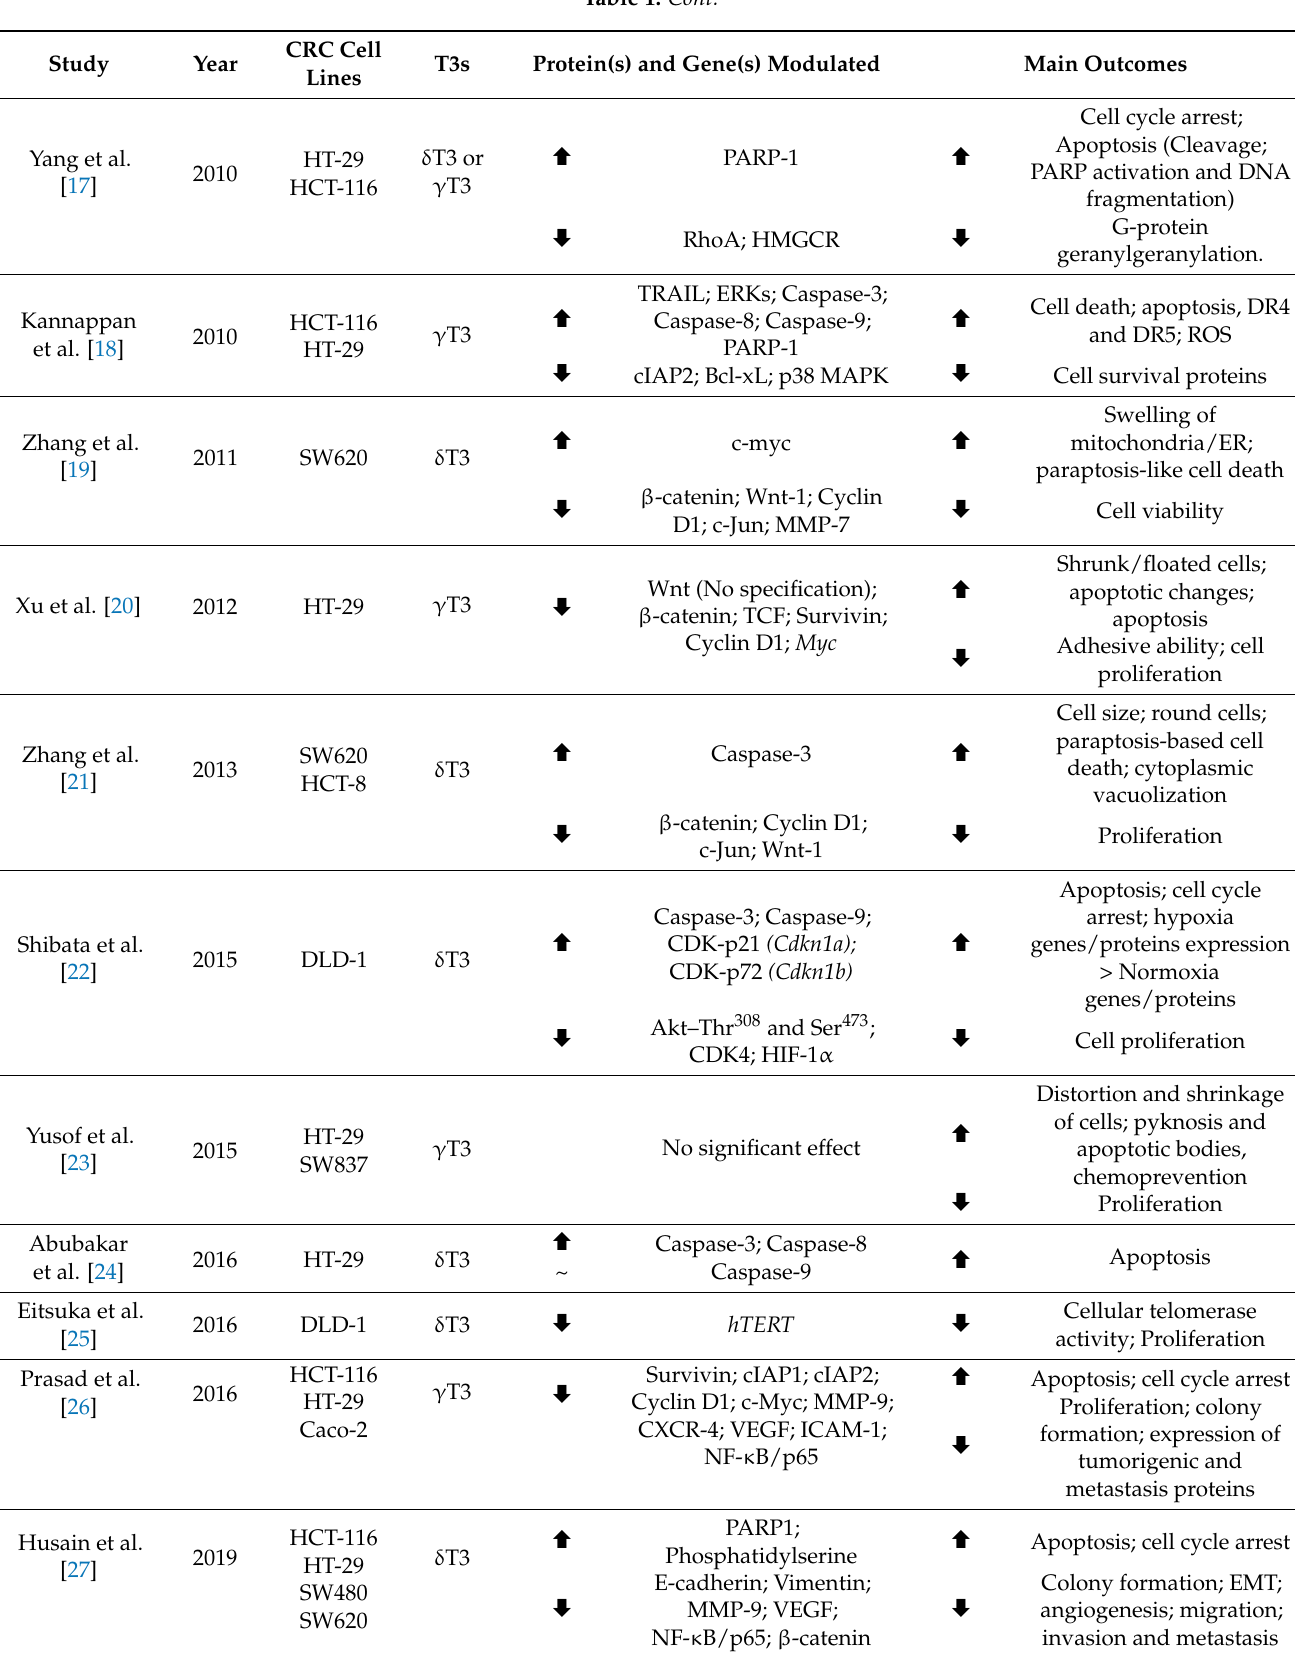
poly (ADP-ribose) polymerase; ROS: reactive oxygen species; T3s: